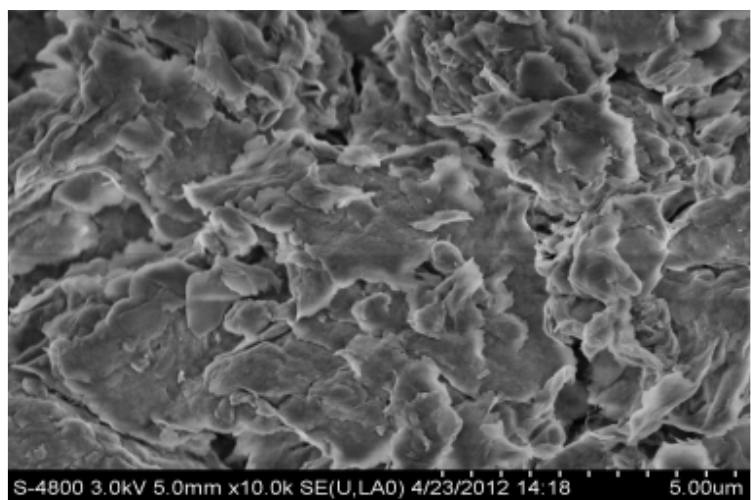
Figure 5. SEM of bentonite soaked in polyamine solution.